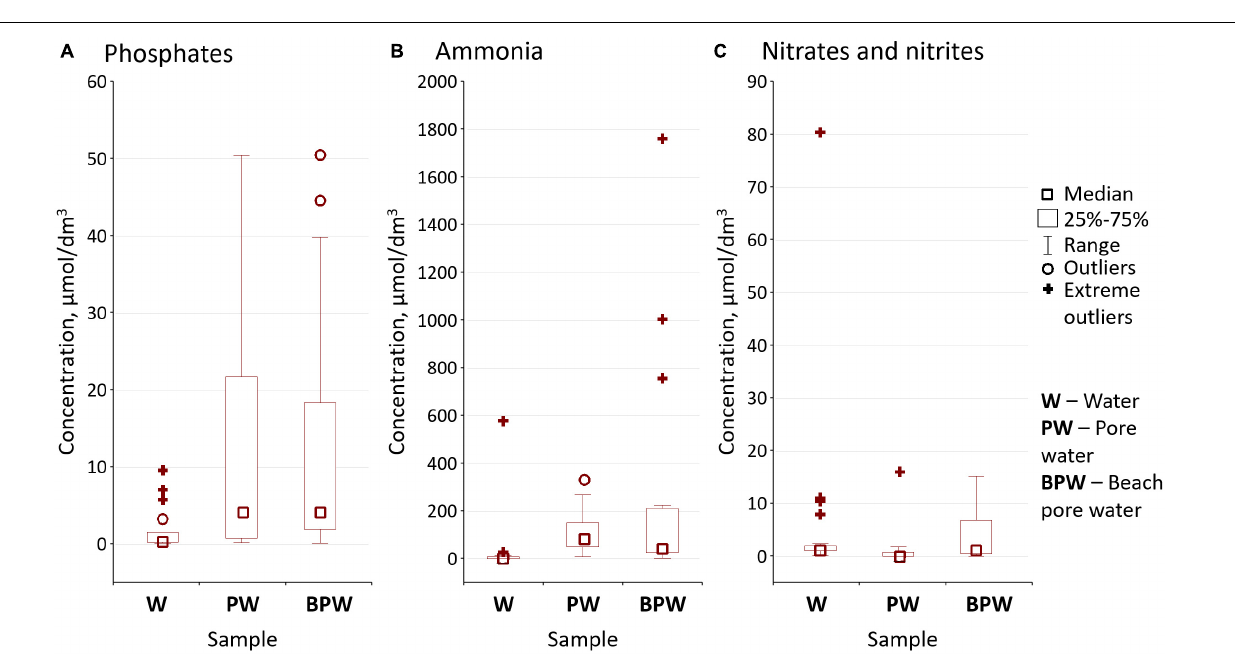
three times higher than those from the managed beach in the same area (P1). This suggests that phosphates and